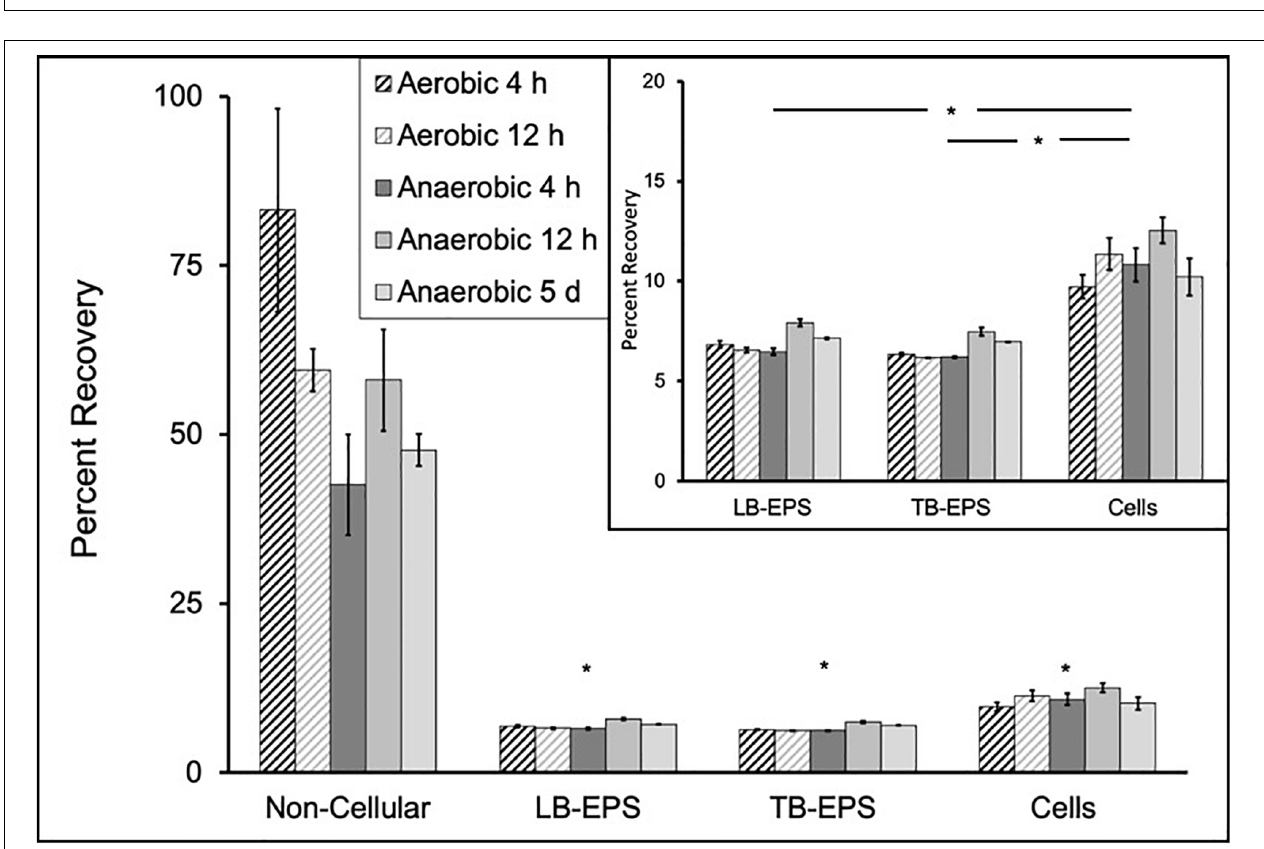
FIGURE 4 | (A) Riboflavin secreted from S. oneidensis upon aerobic exposure to varying concentrations of 25 nm TiO 2 nanoparticles were not statistically different than control cultures (single-factor ANOVA, p = 0.69). (B) Riboflavin secreted by S. oneidensis after aerobic exposure to sheets of polystyrene (PS) and polyethylene (PE) thin films. No statistical difference was observed (single-factor ANOVA, p = 0.58). Trials were performed in triplicate; error bars represent the SEM in triplicate values. Note the different order of magnitudes on the riboflavin secretion for panels (A,B) .